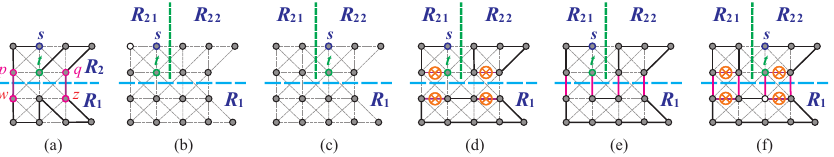
Figure 16. ( a ) A Hamiltonian ( s , t ) -path in C ( m , n ; k , l ; c , d ) , ( b , c ) a vertical and horizontal separations on C ( m , n ; k , l ; c , d ) where 2 (cid:54) s x = t x (cid:54) a − 1, ( d ) a Hamiltonian ( s , t ) -path in R 21 and Hamilto- nian cycles in R 1 and R 22 for ( b ), ( e ) a Hamiltonian ( s , t ) -path in C ( m , n ; k , l ; c , d ) for ( b ), and ( f ) a Hamiltonian ( s , t ) -path in C ( m , n ; k , l ; c , d ) for ( c